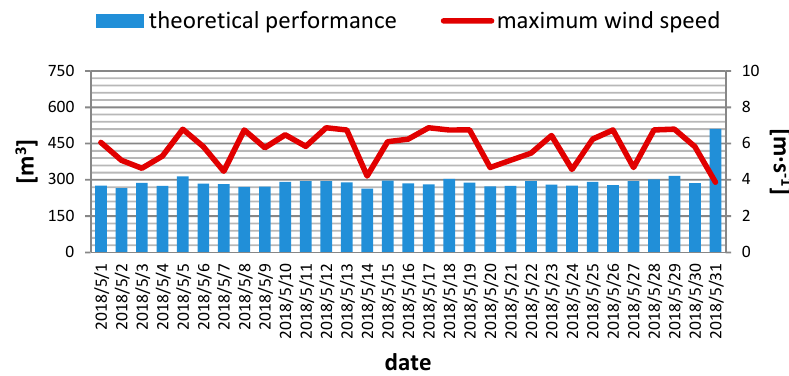
Figure 5. E ffi ciency of the pulverization unit of the aerator in April. Figure 5. Efficiency of the pulverization unit of the aerator in April.